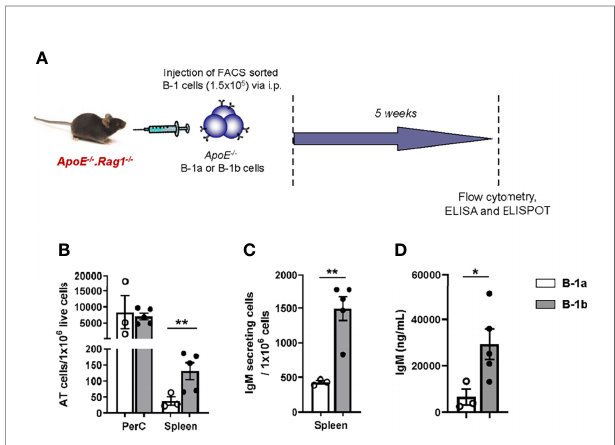
FIGURE 1 | B-1b cells produce more IgM than B-1a cells in vivo , likely due to greater accumulation in the spleen. (A) Schematic representation of the experiment. FACS sorted B-1a or B-1b cells from ApoE -/- mice were adoptively transferred (100,000 cells/mouse) into ApoE -/- Rag1 -/- mice via intraperitoneal injection. (B) Adoptively transferred (AT) cells were quanti fi ed in peritoneal cavity (PerC) and spleen by fl ow cytometry and (C) IgM secreting cells were quanti fi ed in spleen after fi ve weeks of cell transfer. (D) Secreted IgM levels in the plasma were measured after fi ve weeks of cell transfer. B-1a transferred mice (n=3) and B-1b transferred mice (n=5). Data from single experiment. Results are represented in mean + SEM, unpaired t-test performed. *p < 0.05, **p <